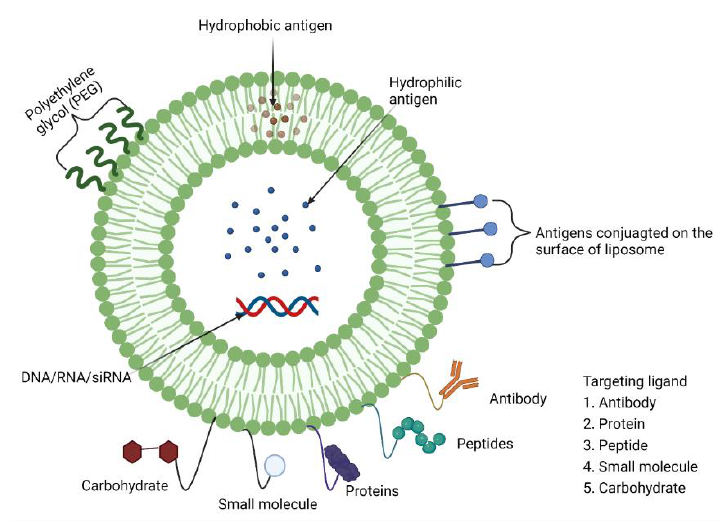
Figure 6. Liposome